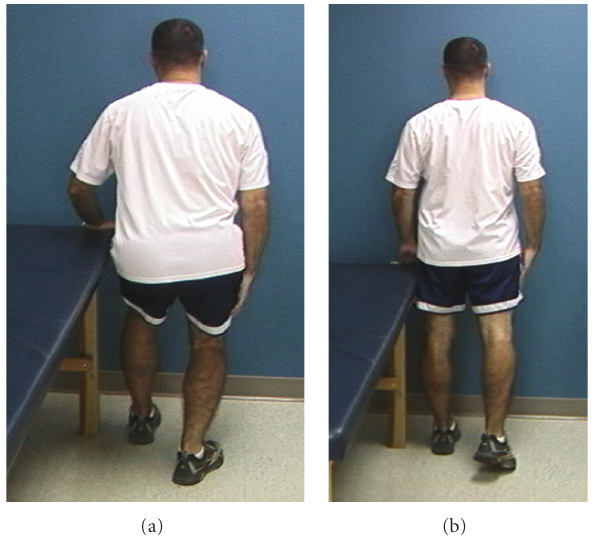
Figure 6: (a) Starting position for low row exercise. (b) Terminal position for low row exercise.